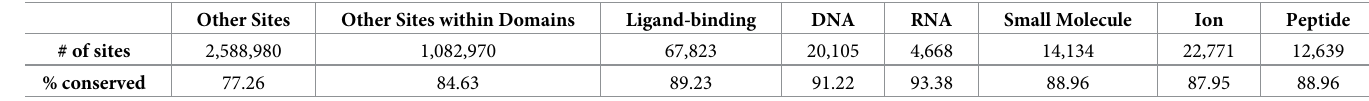
Table 1. Number of ligand-binding sites, other sites, and other sites within domains, and the fraction of these that are conserved. Data for ligand-binding sites are given both when considering all types of ligands together as well as when split up by type of ligand. Note that some sites may participate in interactions with more than one ligand